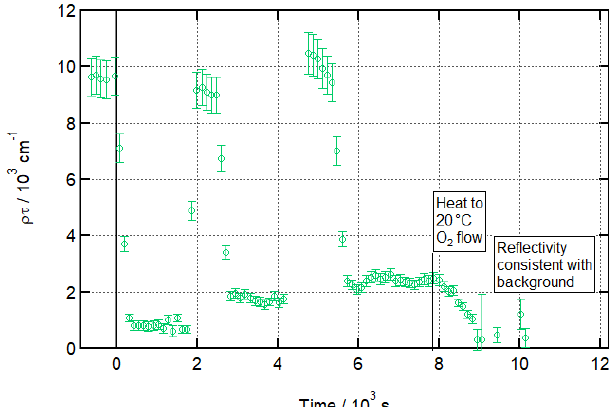
Figure 4. Experiment mimicking an aqueous aerosol droplet ex- posed to multiple cooking emission peaks and demonstrating the as- sociated build-up of an inert organic film at the air–water interface at low temperatures. Time evolution plot for ozonolysis of 25µL 1.0gL − 1 d 34 -OA (CHCl 3 spreading solution) on pure water sub- phase by 323 ± 29ppb O 3 introduced at t = 0s and after two addi-